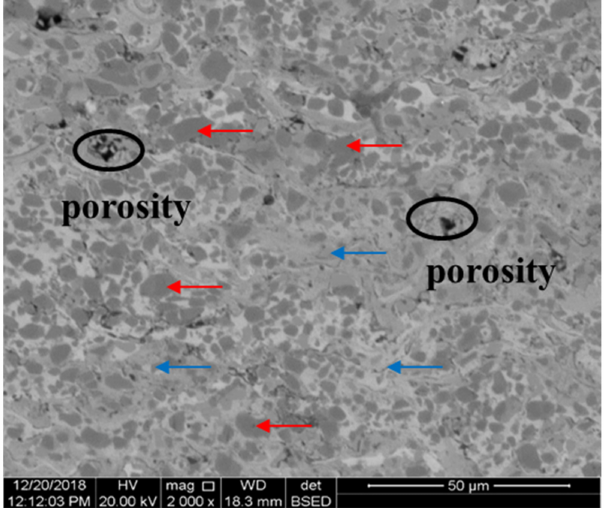
Figure 4. The microstructure of HVOF Cr 3 C 2 –NiCr surface